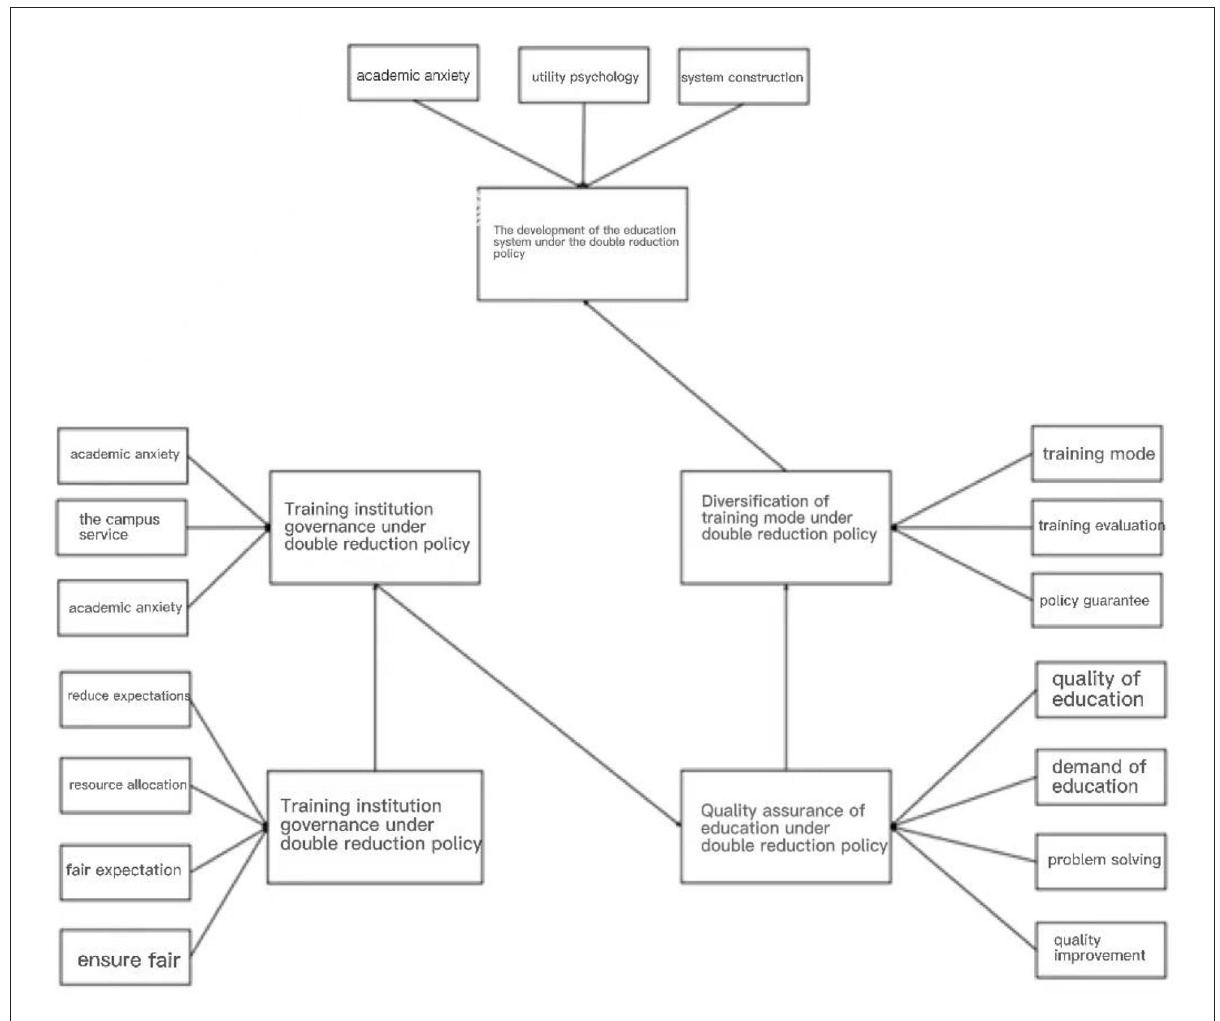
FIGURE1 Structural equation